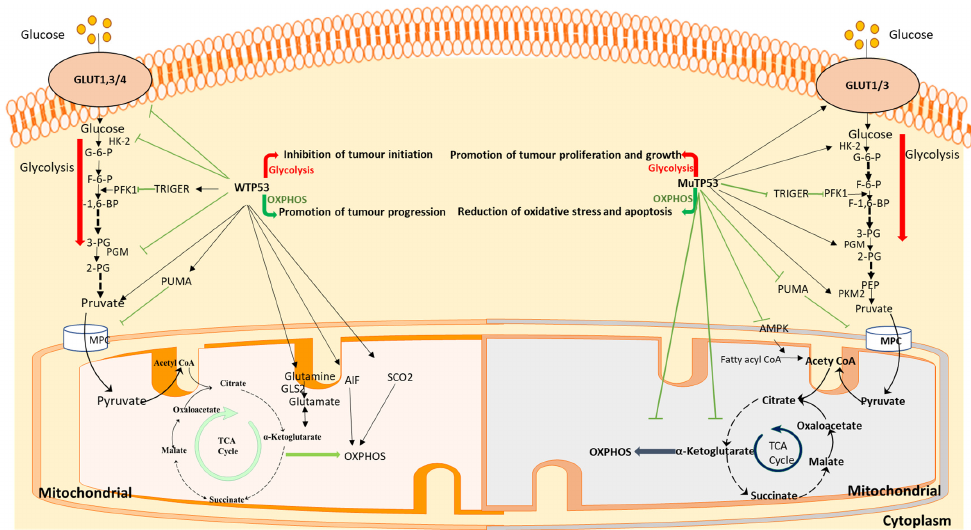
Figure 4. Effects of WTP53 and mutation of MuTP53 on tumour metabolism regulation. P53 can affect the metabolic plasticity process in multiple ways, thus affecting cancer pathogenesis and de-